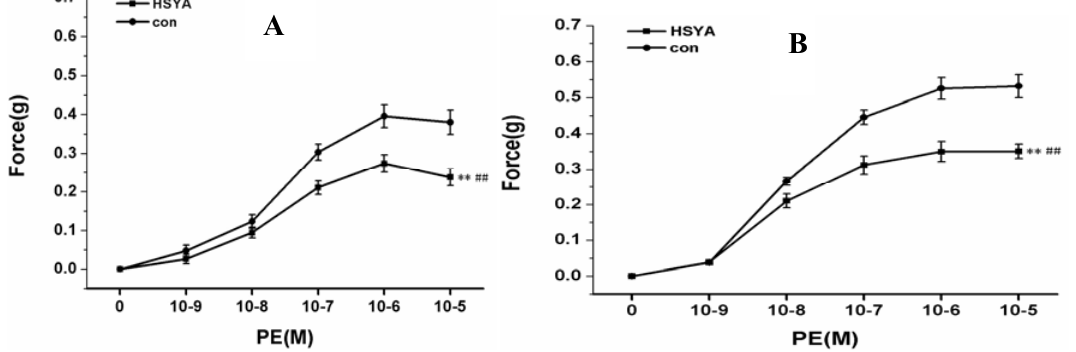
Figure 5. Vascular effect of HSYA on rat PA rings. ( A ) Vascular effect of HSYA on PE-induced vascular constriction in endothelium-intact rat PA rings; ( B ) Vascular effect of HSYA on PE-induced vascular constriction in endothelium-denuded rat PA rings. ** indicates the result has statistical significance ( p < 0.01, compared with Normal). ## p < 0.01 compared with PE.